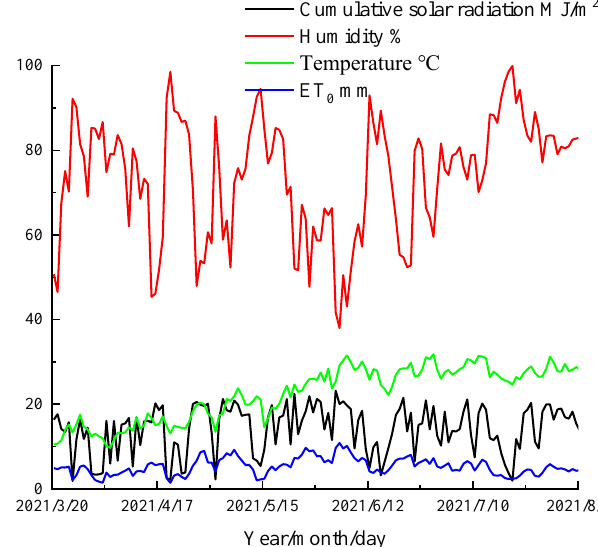
Figure 1. Meteorological data.